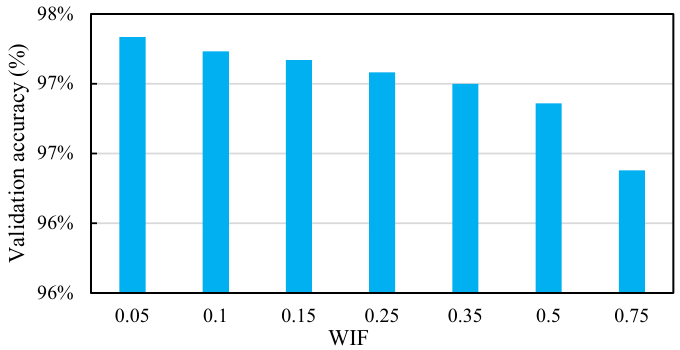
Figure 5. Validation of the accuracy of the water body classification in 2019 using different WIF thresholds.